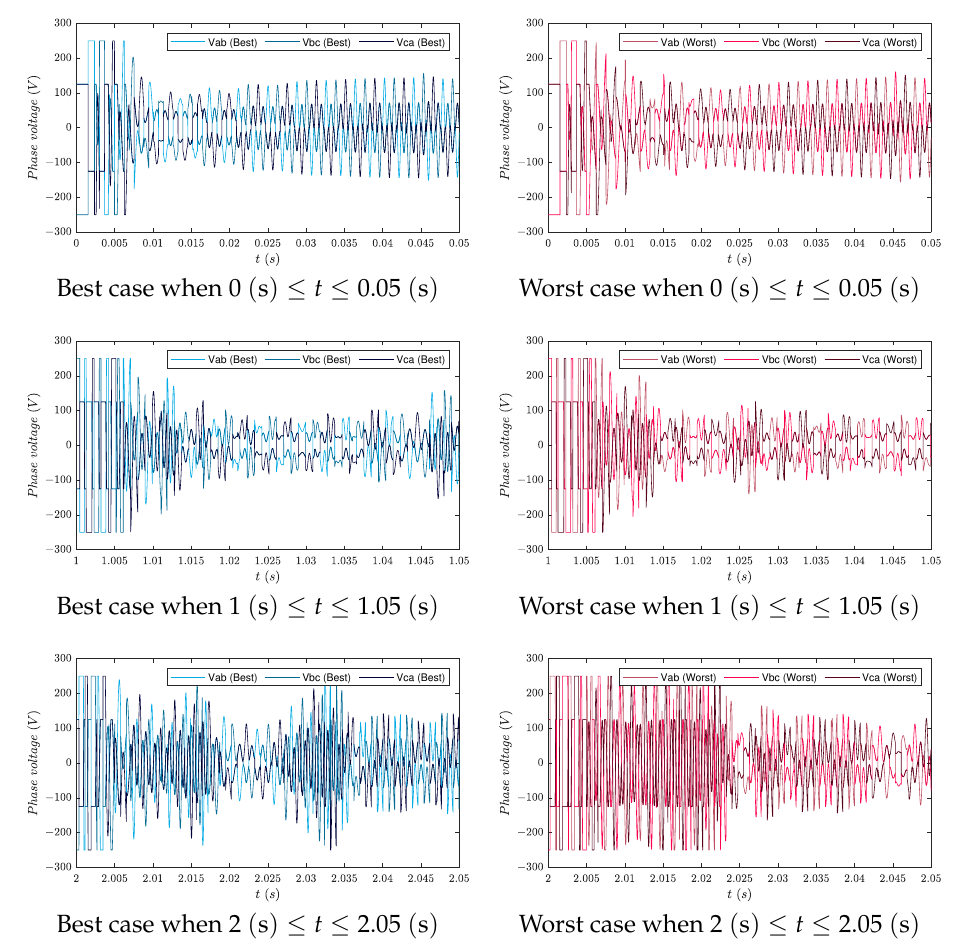
Figure 10. Phase voltages in the motor obtained with the best and worst runs of CATSCG, consider- ing